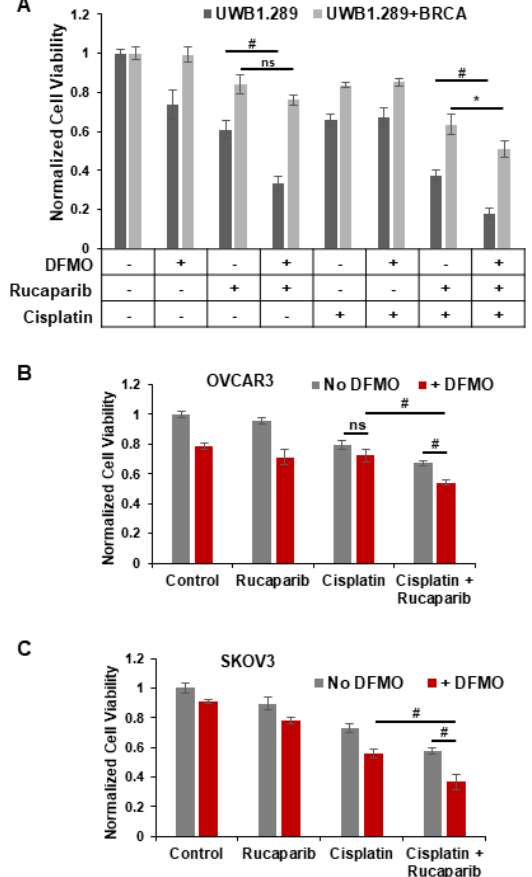
Figure 5. DFMO and rucaparib treatment enhances cytotoxicity of cisplatin in ovarian tumor cell lines. ( A ) UWB1.289 and UWB1.289+BRCA cells were pretreated with 0.2 mM DFMO for 24 h prior to treat- ment with 25 µM rucaparib and a 2 h pulse with 1.5 µg/mL (5 µM) cisplatin. Viability was assessed 72 h after cisplatin treatment. ( B ) OVCAR3 cells were pretreated with 1 mM DFMO for 40 h prior to treatment with 10 µM rucaparib and a 3 h pulse with 4 µg/mL cisplatin. Viability was assessed 72 h later. ( C ) SKOV3 cells were pretreated with 0.1 mM DFMO for 24 h prior to treatment with 7 µM rucaparib and a 2 h pulse with 3 µg/mL cisplatin. Viability was assessed 72 h after cisplatin treat- ment, and all values were normalized to untreated control. # p ≤ 0.01; * p < 0.05. 4. Discussion This study shows that a low cytotoxic dose of DFMO significantly increases rucaparib-induced DNA damage and cytotoxicity in ovarian cancer cells regardless of HR repair status. DFMO acts in a multifaceted way to enhance the cytotoxic effects of PARP inhibitors, suggesting that it may be a useful adjunct chemotherapeutic approach to im- prove the anti-tumor efficacy of PARP inhibitors in treating ovarian cancer. Polyamines have roles in the repair of not only dsDNA breaks, but also ssDNA breaks by serving as a co-factor for PARP (Figure 6). Polyamines stimulate the enzymatic activity of PARP1 (via